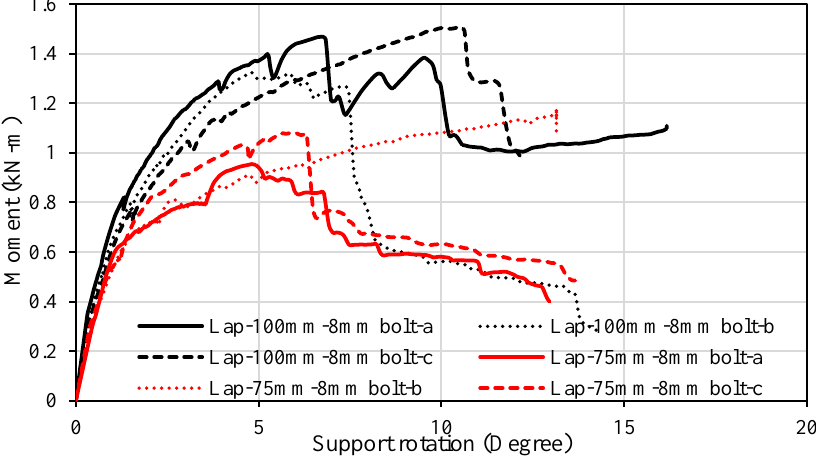
Figure 6. Moment capacity vs. support rotation curves of the Ø 8mm bolted lap connections with different lap lengths.